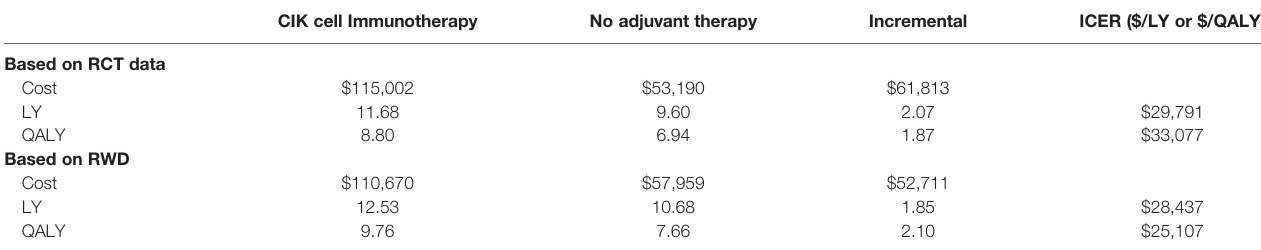
TABLE 2 | Result of the cost-effectiveness